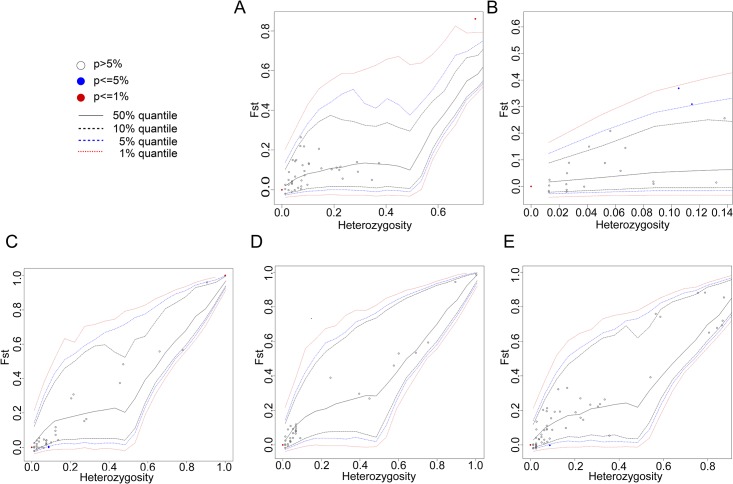
Differentiated loci between partial Chinese domestic geese and Landes geese. (A) COX2, (B) COX3, (C) HBA1, (D) HBA2, and (E) HBB.FST: locus-specific genetic divergence among populations. Heterozygosity: measure of heterozygosity per locus. Single-locus FST values are plotted against heterozygosity, with the red-filled circles representing loci significant at the 1% level, and blue-filled circles representing loci significant at the 5% level.